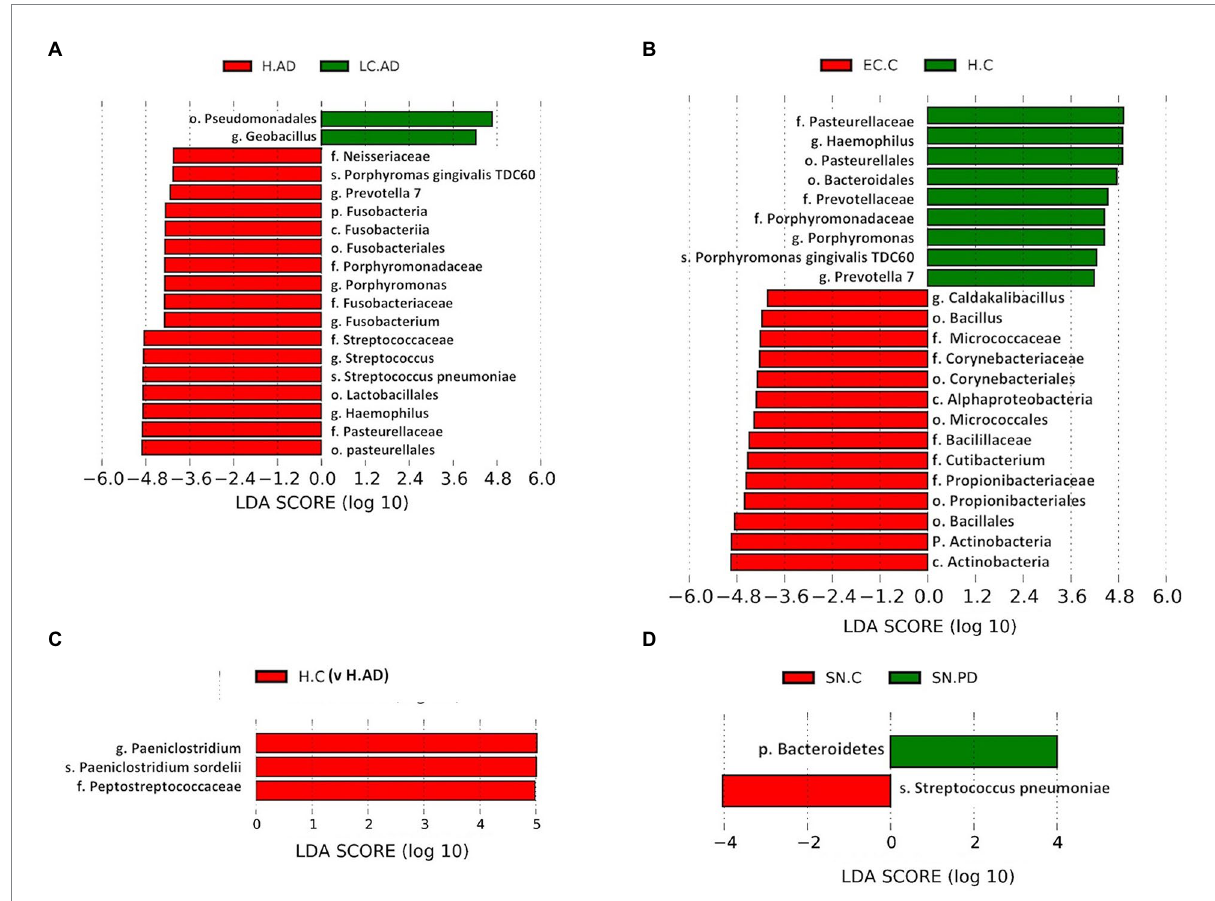
FIGURE 8 (A-D) : LEfSe analysis of differentially abundant taxa. T -tests highlight taxa abundance significant differences with four pairings: H-AD/LC-AD (A) ; H-C/EC-C (B) ; H-AD/H-C (C) ; and SN-C/SN-PD (D) . C, Control; AD, Alzheimer’s disease; PD, Parkinson’s disease; EC, entorhinal cortex; H, hippocampus; LC, locus coeruleus; SN, substantia